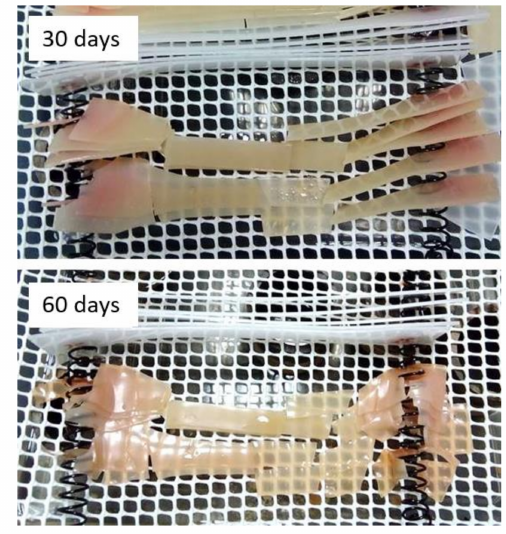
Figure 9. PBS samples under 30 and 60 aging